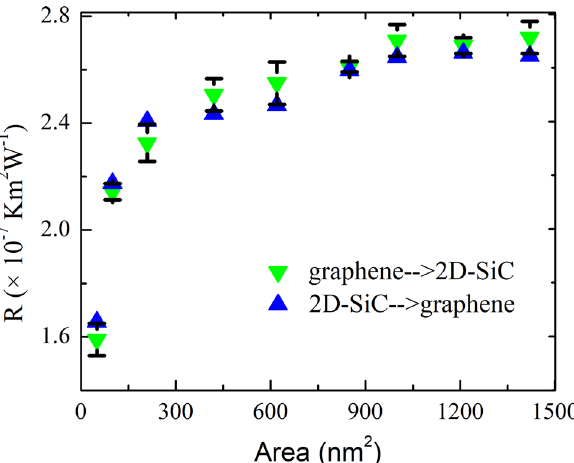
Figure 12. Interfacial thermal resistance of the graphene/2D-SiC heterobilayer for both graphene to 2D-SiC and 2D-SiC to graphene projection with variation of heterobilayer area from 50 to 1420 nm 2 . Fitted data of graphene to 2D-SiC corresponds well with the MD simulation results.